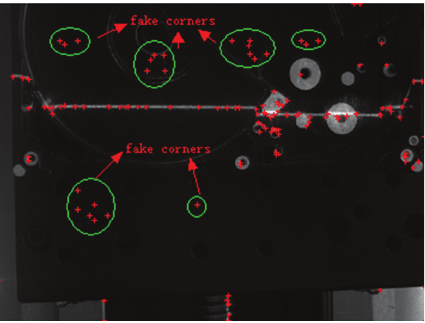
Figure 4: Fake corners in an image processed by the Harris algorithm.